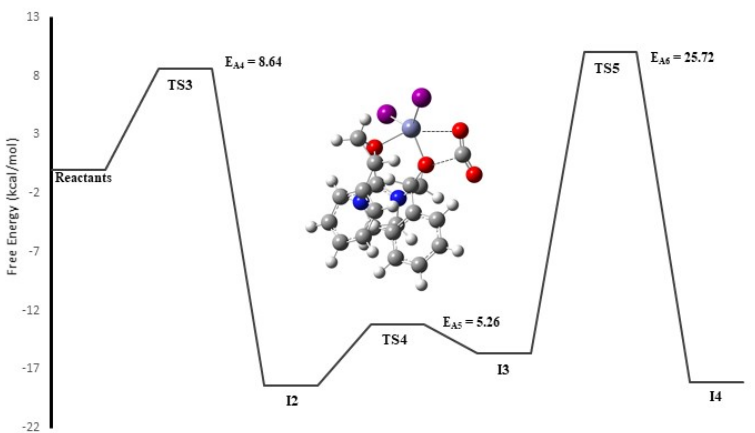
Figure 11. Free energy diagram (kcal/mol) of HIm/ZnI 2 catalyzed transformation of styrene oxide (SO) to styrene carbonate (SC).